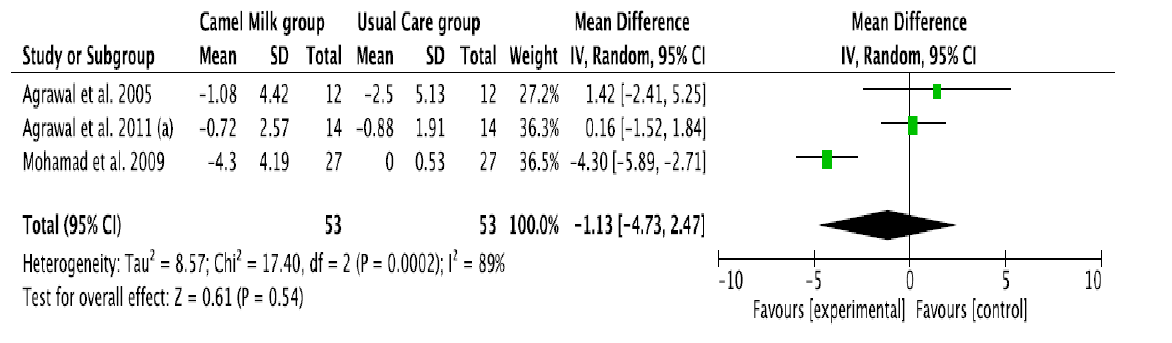
between the two articles that are published by same author (Agrawal), same year. Figure 8. Forest plot for the effect of CM intake on circulating insulin antibody (IA). (a): difference